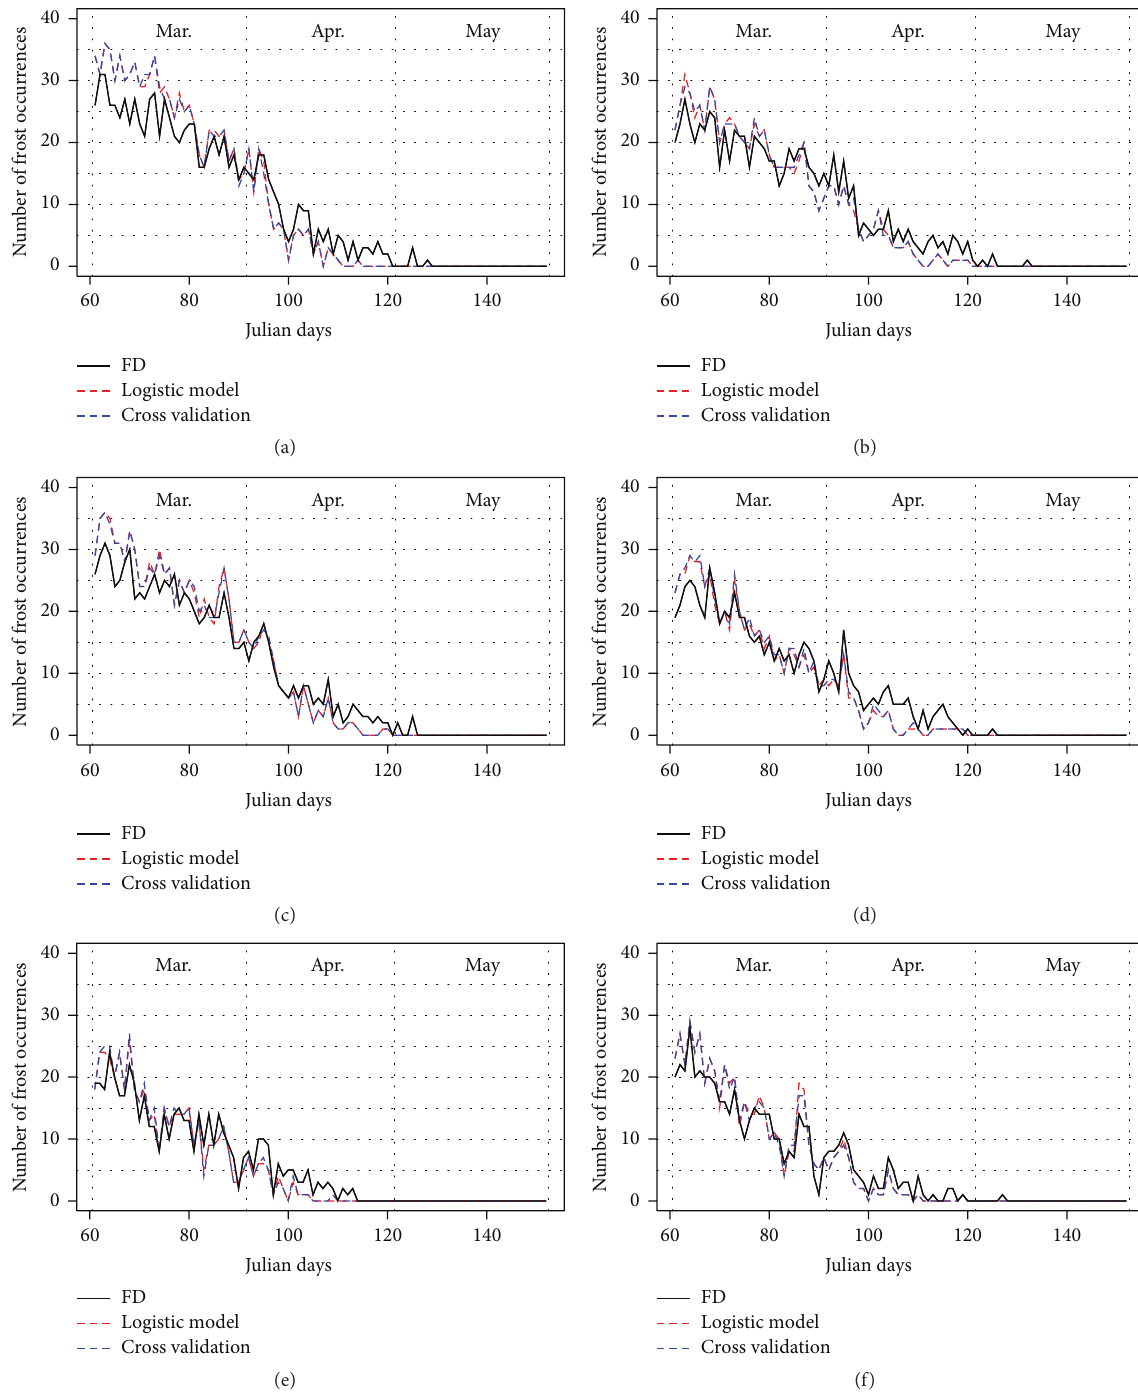
Figure 2: Observed and predicted frost in spring using the logistic regression models: (a) Chuncheon (101), (b) Suwon (119), (c) Seosan (129), (d) Cheongju (131), (e) Gwangju (156), and (f) Jinju (192).